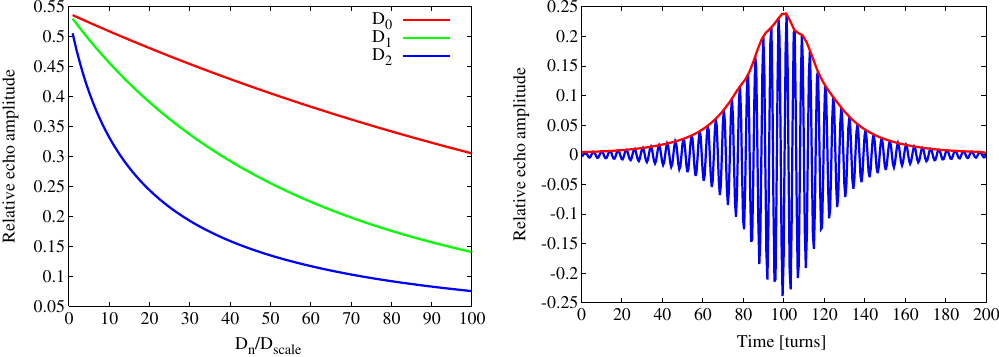
¼ 2 . 4 × 10 − 15 m 2 = s. scale